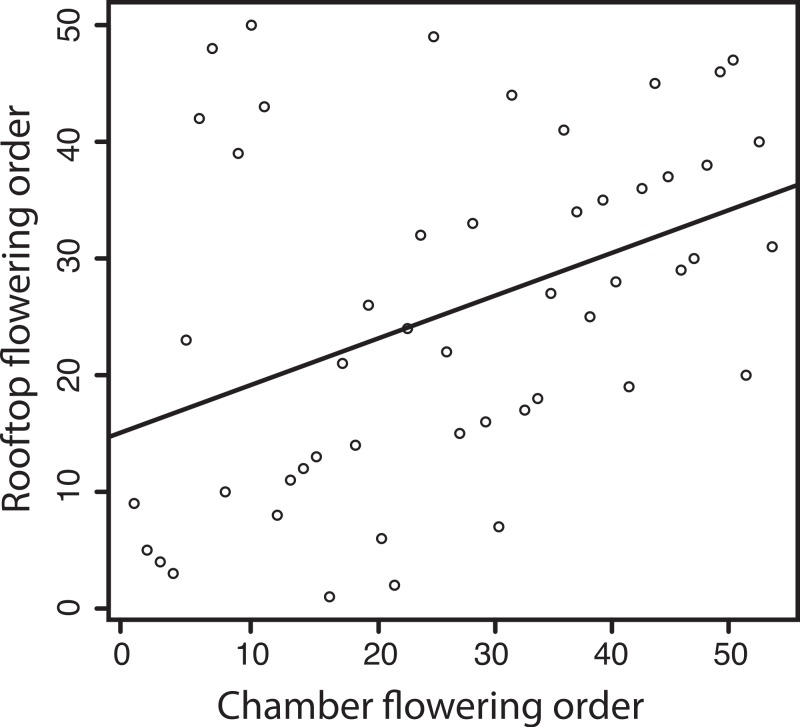
Correlation between flowering times of lines grown in our chamber experiment, and the same lines grown for a study by Samis et al. (2012) in an outdoor roof setting.For clarity, we portray the mean phenotype of lines in the chamber experiment, including both high and low water treatments.